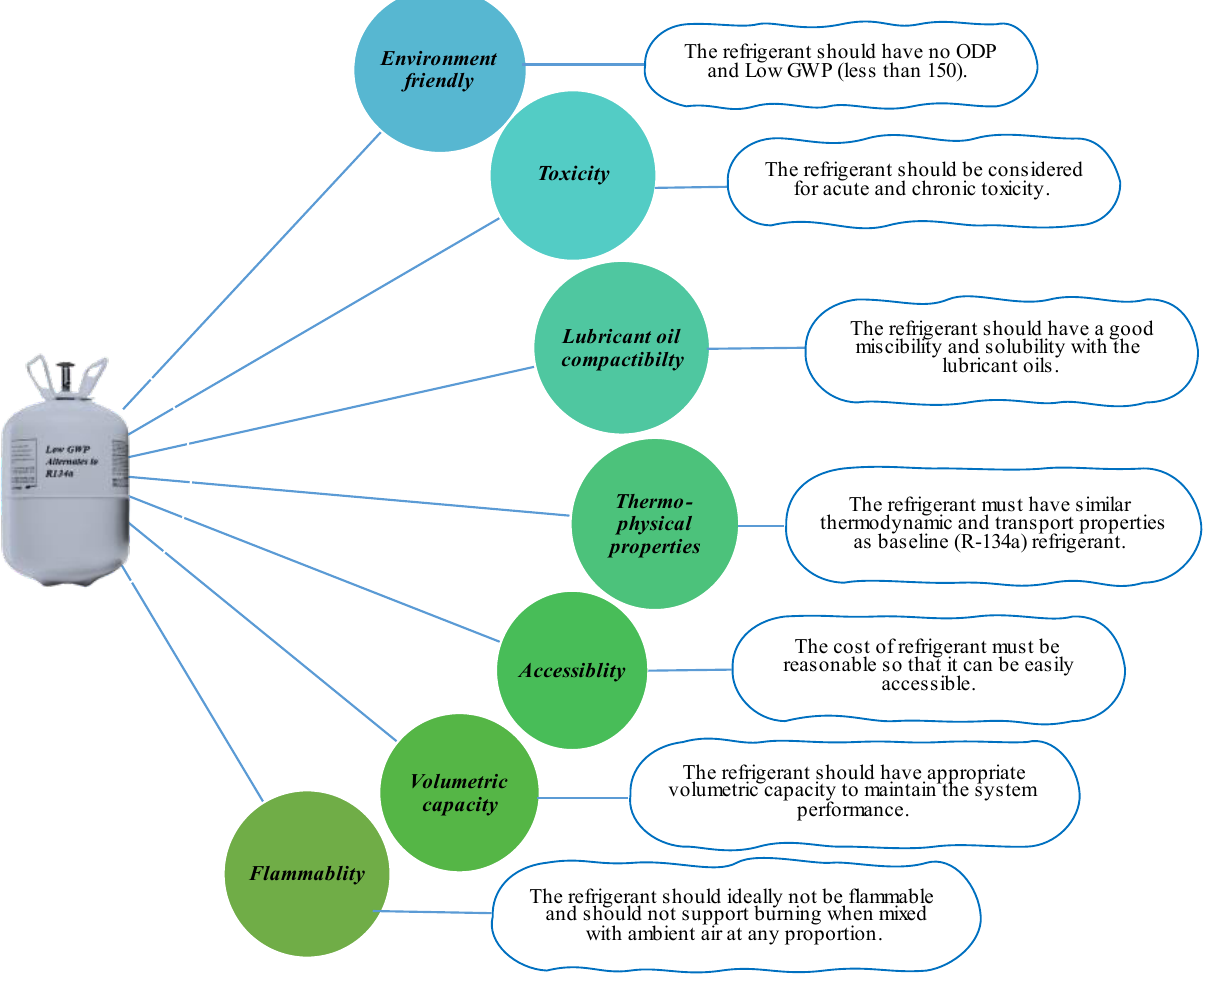
Figure 1. Characteristics of environmentally benign ideal refrigerants.